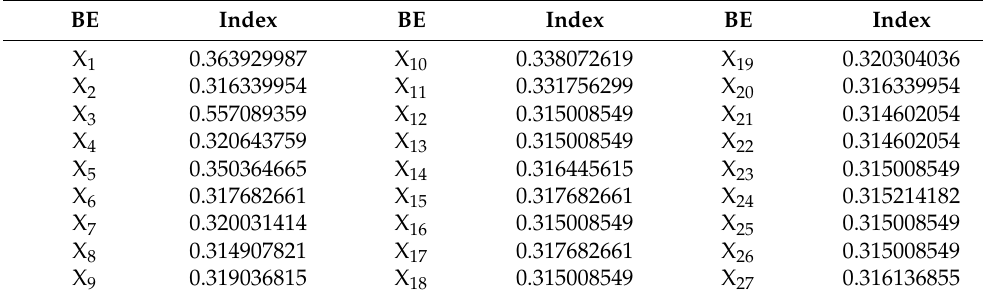
Table 16. Importance ranking of each